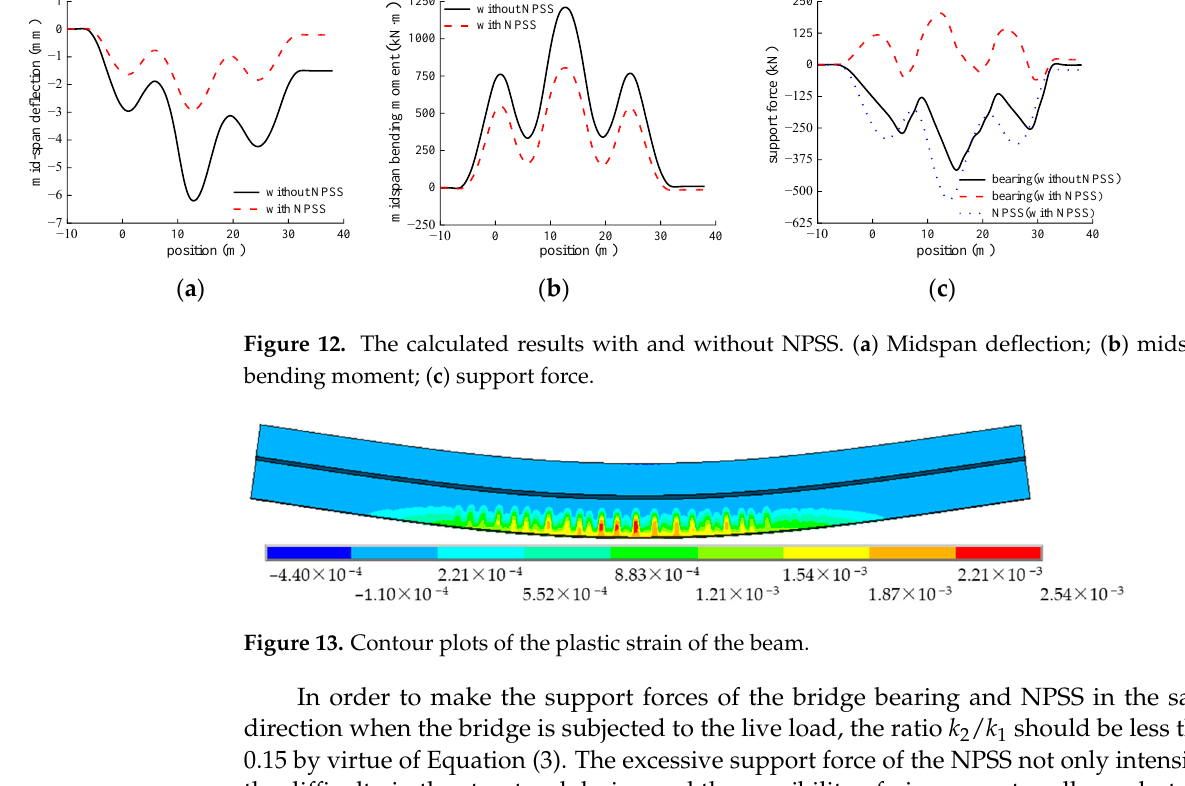
Figure 12. The calculated results with and without NPSS. ( a ) Midspan deflection; ( b ) midspan bending moment; ( c ) support force.